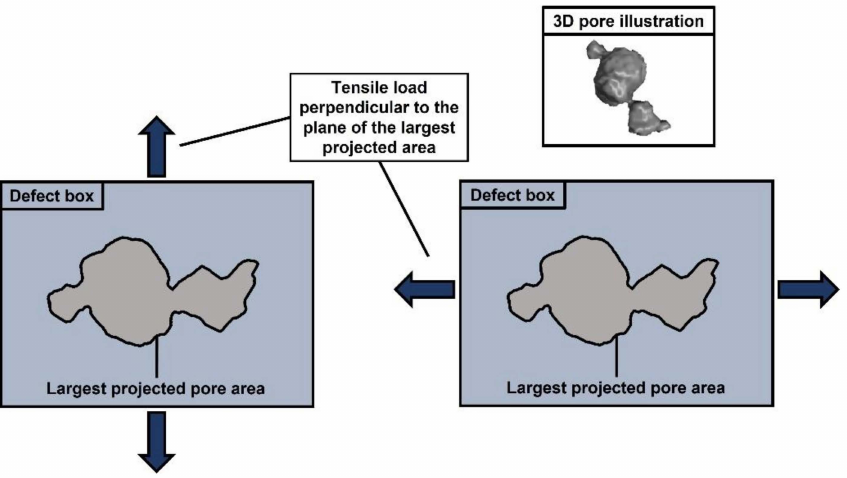
Figure 8. Illustration of a defect box and the performed tensile load perpendicular to the plane of the largest projected